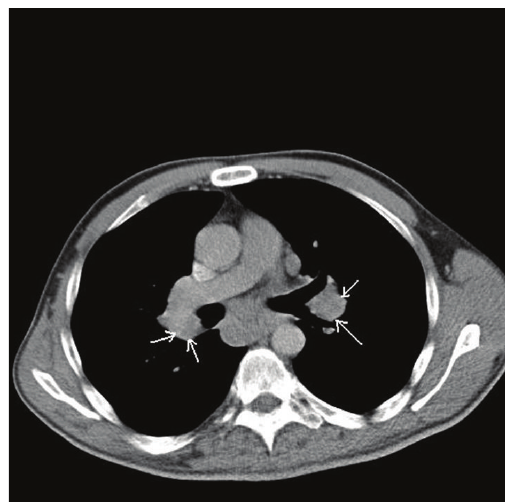
Figure 2: Thorax CT showed multiple mediastinal and hilar